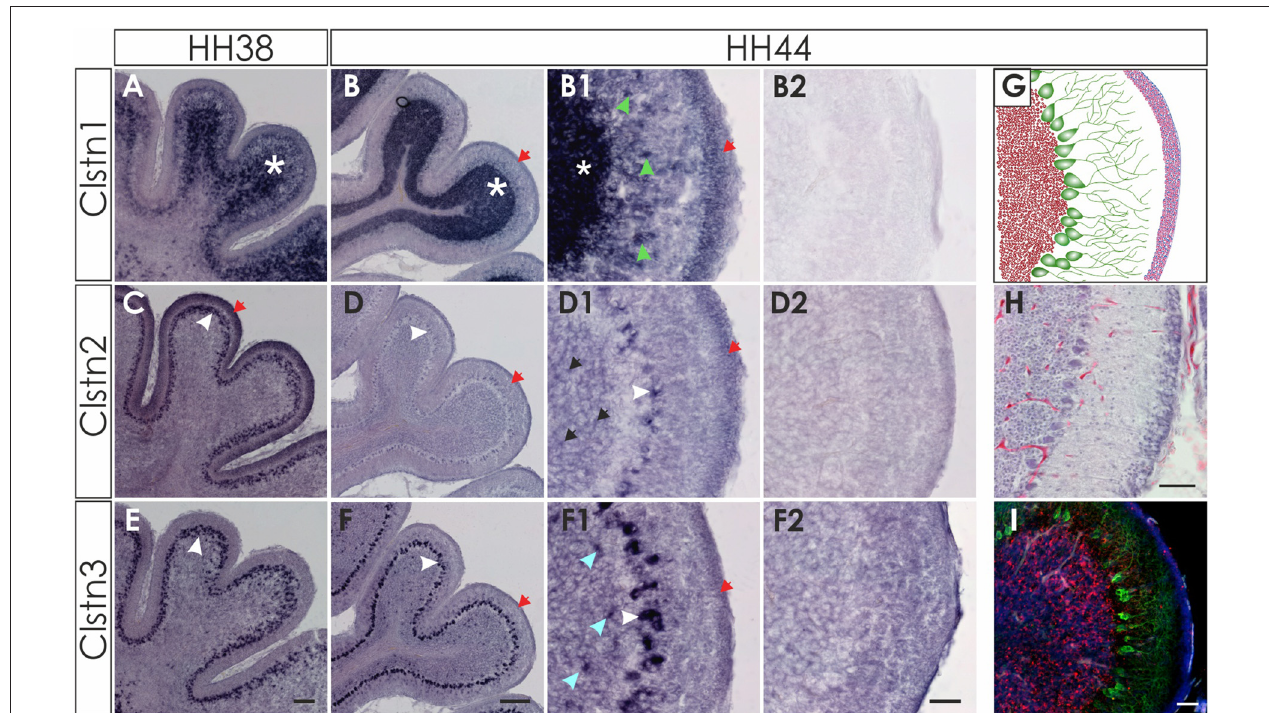
FIGURE 8 | Clstn2 and Clstn3 are mainly expressed in in Purkinje cells. Clstn1 is expressed in the IGL at HH38 ( A ; white asterisk) and at HH44 (B) . Because the Clstn1-positive cells differed in size, we concluded that they are not only granule cells but also other cell types. Clstn1-positive interneurons were also found in the molecular layer (ML; B1 ; green arrowhead). Some of the cells in the ML are most likely late migrating granule cells, as Clstn1 mRNA was still found in the EGL at HH44 (red arrow). Clstn2 expression was restricted to Purkinje cells (white arrowhead) at HH38 (C) and HH44 (D) . At HH44, levels were clearly lower and not all Purkinje cells were positive for Clstn2 mRNA. Some Clstn2-positive cells were also detected in the IGL (black arrow). Clstn3 expression was very similar to Clstn2 at these late stages. Expression was found in Purkinje cells (white arrowhead) at HH38 (E) and HH44 (F) . Similar to Clstn2, some interneurons in the IGL also expressed Clstn3 (blue arrowhead). (B2,D2,F2) Are equivalent sections to those shown in (B1,D1,F1) , but processed with the respective sense probes. (G–I) By HH44, the cerebellum has almost reached maturity. (G) Schematic drawing of granule cells in the IGL (red), Purkinje cells with their dendritic trees (green) and the granule cells in the remaining EGL (pink). (H) H&E staining of a sections taken from the same cerebellum as (B,D,F) . (I) adjacent section to (H) stained with antibodies against Calbindin (green) to visualize Purkinje cells, antibodies against NeuN (red) and DAPI (blue). Bar: (A,C,E) 100 µ m, (B,D,F) 200 µ m; (B1–I) 50 µ